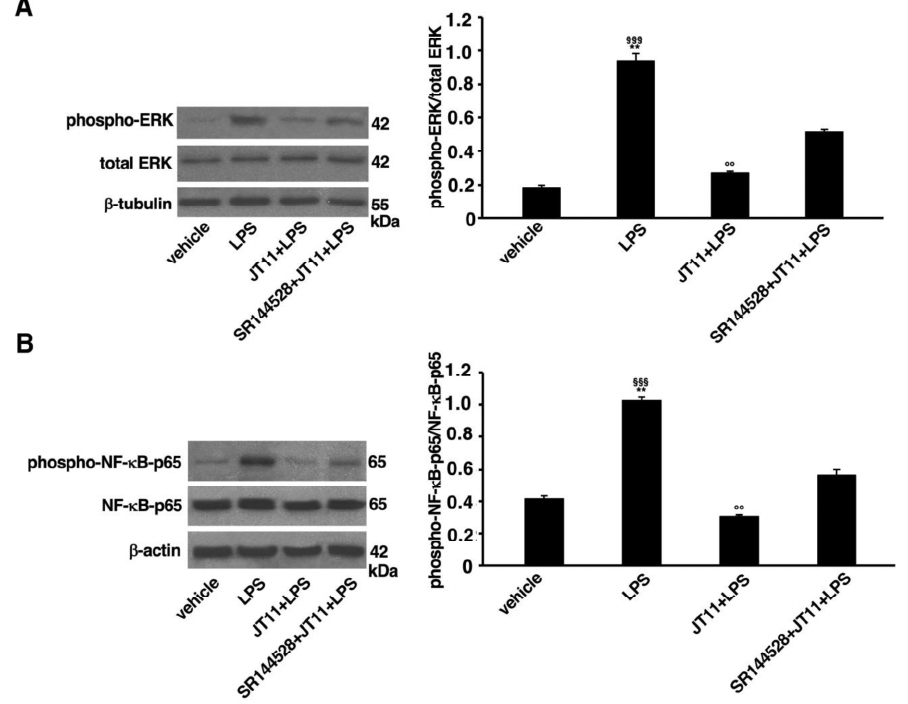
Figure 5. JT11 modulates the pro-inflammatory signal activated by bacterial lipopolysaccharide (LPS) in human peripheral blood mononuclear cells (PBMCs). PBMCs from healthy donors were pretreated for 1 h with JT11 (2 μ M) and then stimulated with LPS (100 ng/mL) for 1 h. Alternatively, PBMCs were analyzed in presence of selective CB2R antagonist SR144528 (1 μ M). Analysis of the phosphorylated ERK1/2 ( A ) and p65 subunit of nuclear factor- κ B (NF- κ B-p65) ( B ) by Western blot. Protein extracts were separated by SDS-PAGE (10% acrylamide) and analyzed using anti-phospho-ERK1/2, anti-ERK1/2, anti-phospho-NF- κ B-p65 and anti-NF- κ B-p65 Abs. Densitometric phosphor-ERK1/2/total ERK1/2 and phospho-NF- κ B-p65/total NF- κ B-p65 ratios are shown in the right panels of the figure. Data are reported as mean ± SD from three independent experiments. Statistical analysis indicated: ** p < 0.001 vs. vehicle; §§§ p < 0.0001 vs. JT11 + LPS; °° p < 0.001 vs. SR144528 + JT11 + LPS.